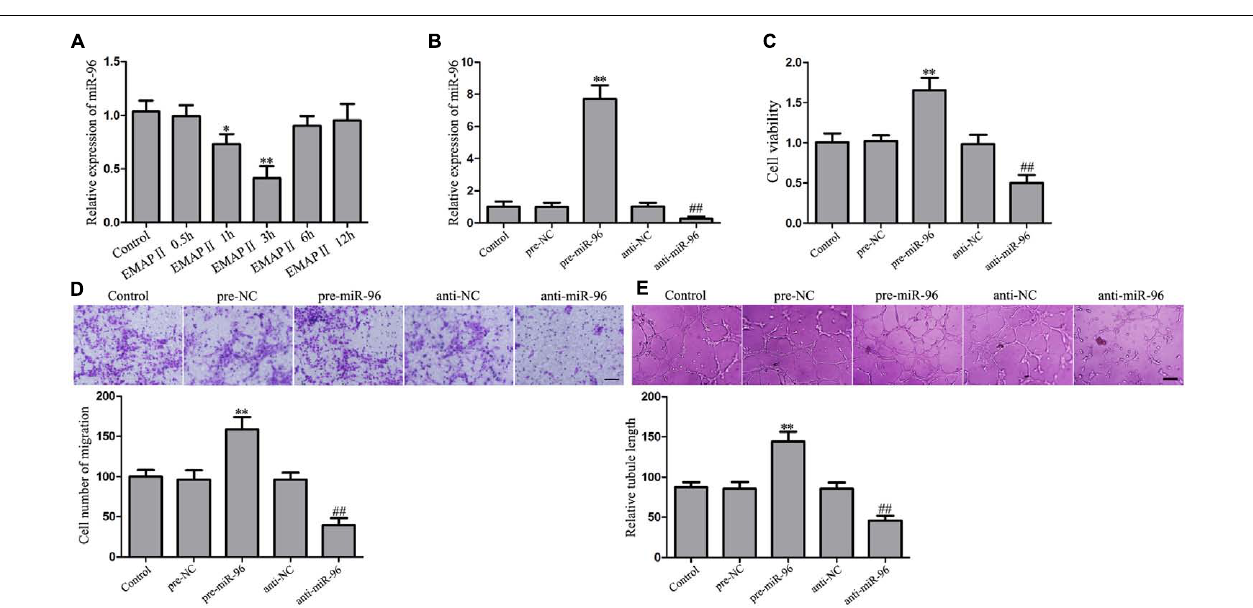
FIGURE 6 | Effect of EMAP II on the miR-96 expression, and miR-96 on the viability, migration, and tube formation of GECs. (A) Relative miR-96 expression after GECs treated with 0.05 nM EMAP II for 0.5, 1, 3, 6, and 12 h. Data represent means ± SD ( n = 5, each). ∗ P < 0.05 and ∗∗ P < 0.01 vs. control group. (B) Relative miR-96 expression after GECs transfected with miR-96 agomir and miR-96 antagomir. (C) CCK8 assay to evaluate the effect of miR-96 on the GECs viability. (D) Transwell assay to evaluate the effect of miR-96 on the GECs migration. Scale bar = 80 µ m. (E) In vitro tube formation assay to evaluate the effect of miR-96 on the GECs tube formation. Scale bar = 100 µ m. Data represent means ± SD ( n = 5, each). ∗∗ P < 0.01 vs. pre-NC group, ## P < 0.01 vs. anti-NC